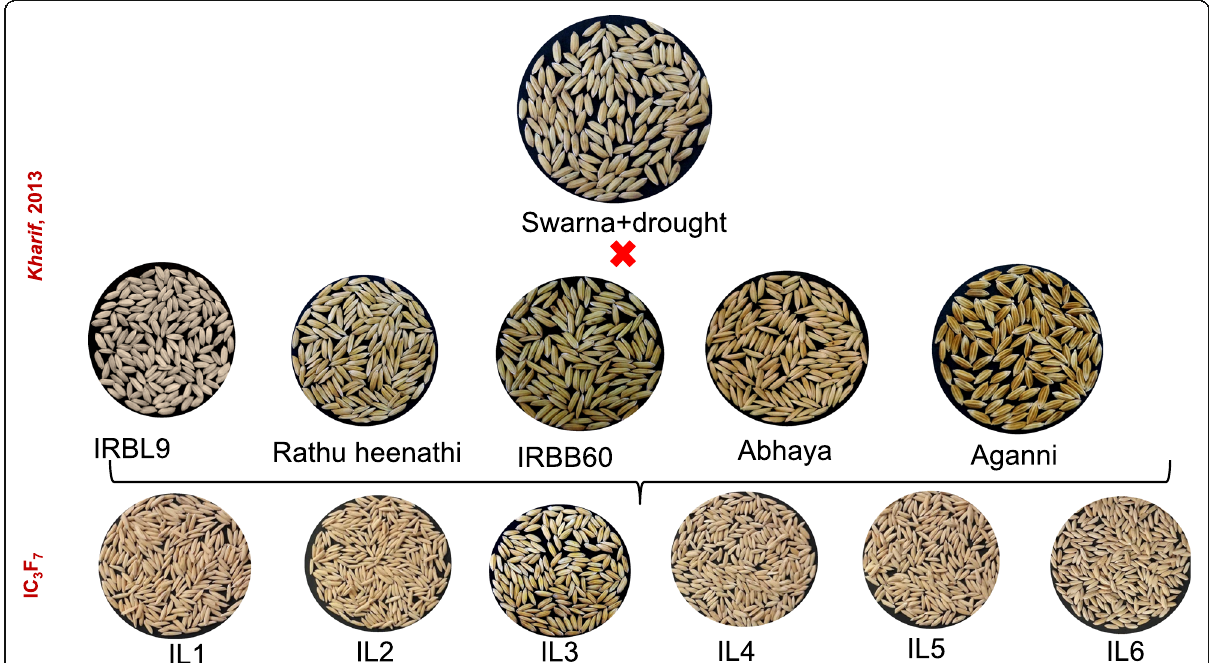
Fig. 3 Representative grain picture of the identified ILs with 7 – 10 genes pyramided in the background of Swarna + drought Grain picture of representative six ILs along with recurrent and all the donor parents used in the breeding program. Grain shape and size of ILs has been affected by the grain type of the donors used in the breeding programs. Grain type of most of the ILs is of medium slender (MS) type except for IL1 and IL2 which are long slender (LS)